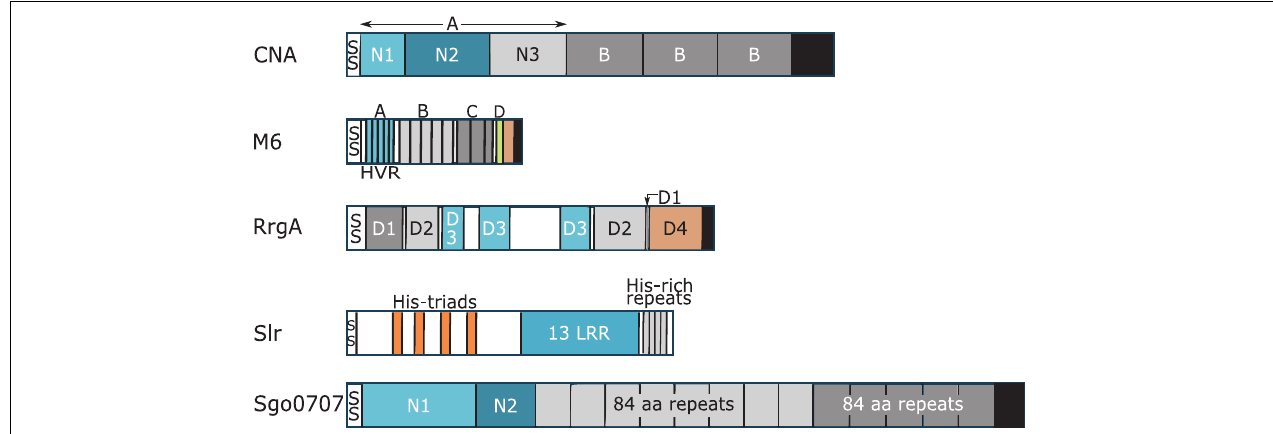
FIGURE 1 | Cartoon representation showing domain organization of collagen binding proteins. Each protein has a signal peptide (SS) at the N-terminus. With the exception of Slr, each protein has a LPXTG motif, and a cell wall-spanning transmembrane region (black). Confirmed and putative collagen-binding domains in the proteins are colored in blue. Where two domains are involved in collagen binding, the first domain is light blue and the second domain is colored darker blue. Proline-glycine rich region of M6 protein is shown in salmon color.